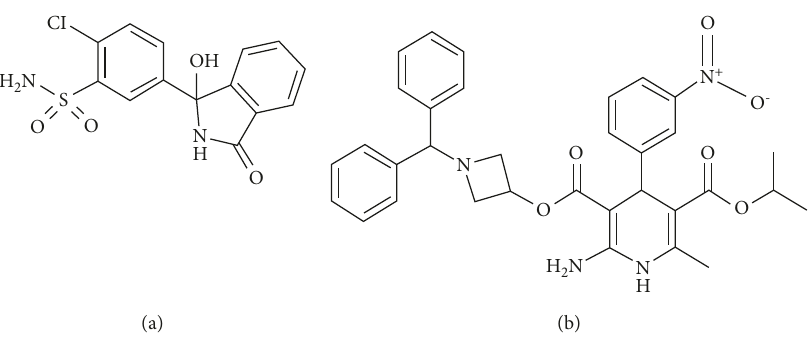
Figure 1: Chemical structure of (a) chlorthalidone and (b)